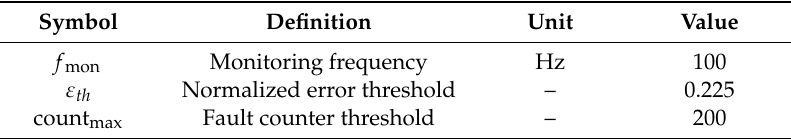
Figure 11. Performances of the condition-monitoring algorithm: ( a ) MBIT.a ; ( b ) MBIT.b . Table 3. Condition-monitoring algorithm parameters.